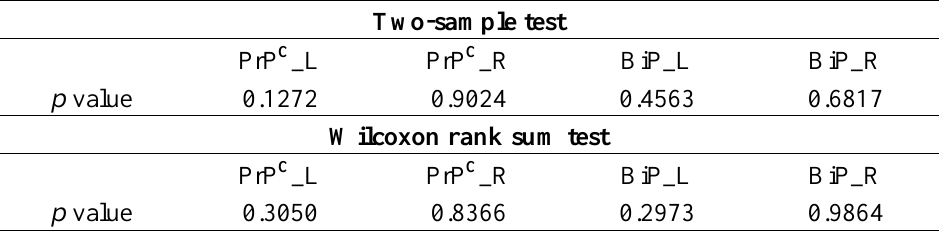
Table 4. Association test p values results for region of residency: PrP C and BiP/GRP78 expression in left and right ventricles for North vs. South Mexico City residents.